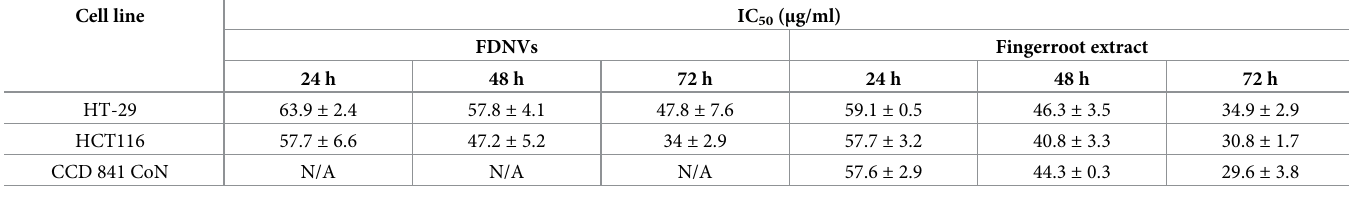
Table 2. IC 50 values of FDNVs and fingerroot extract against colorectal cancer cells. Cell